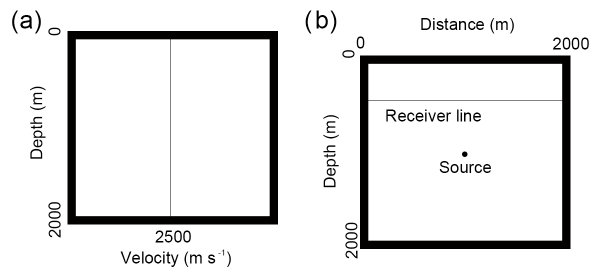
Figure 11. (a) Velocity profiles in depth; (b) distribution of source and